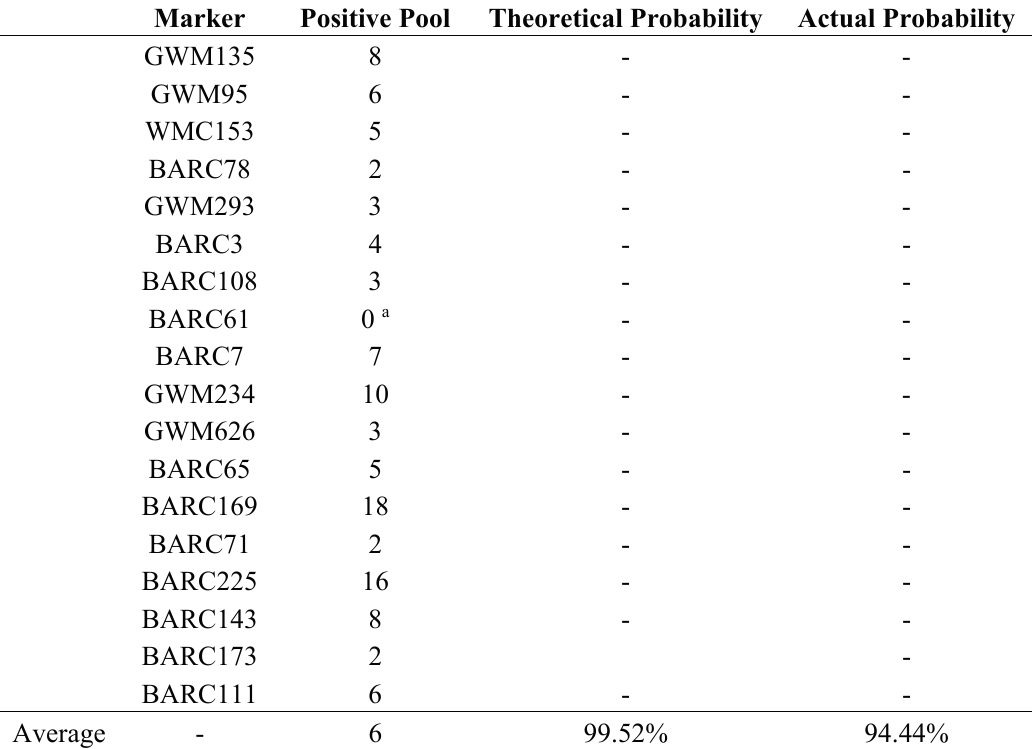
Table 3. Characterization of the genome coverage of the Wangshuibai library by PCR amplification. Marker Positive Pool Theoretical Probability Actual Probability